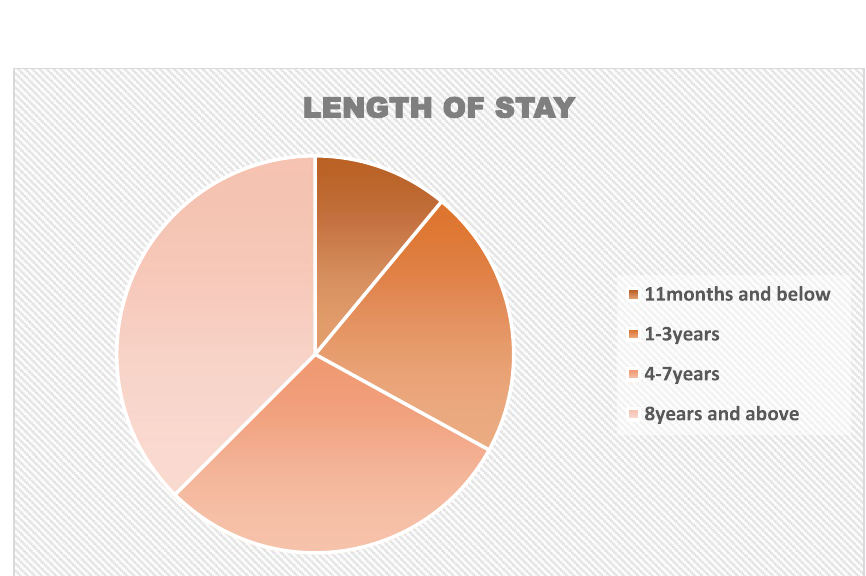
Fig. 7 How long the respondents have been in Hunan province